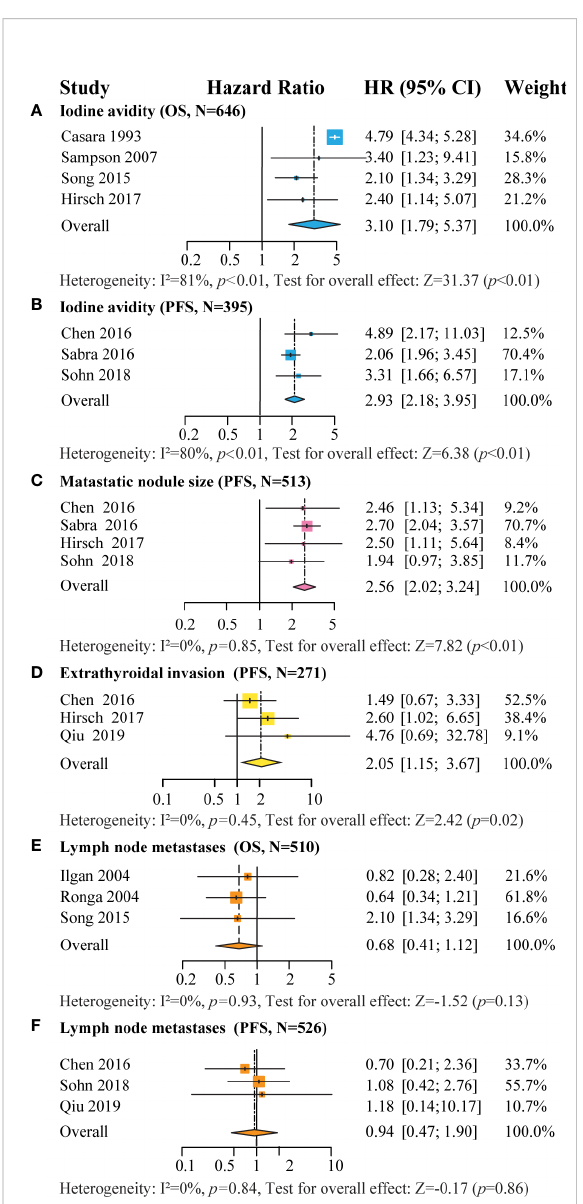
FIGURE 4 Forest plot for the association of: (A) iodine avidity with OS (non- avidity vs. avidity), (B) iodine avidity with PFS (non-avidity vs. avidity), (C) metastatic nodule size with PFS ( ≥ 10mm vs. <10mm), (D) extra thyroid invasion with PFS (with vs. without), (E) LNM with OS (with vs. without), (F) LNM with PFS (with vs.